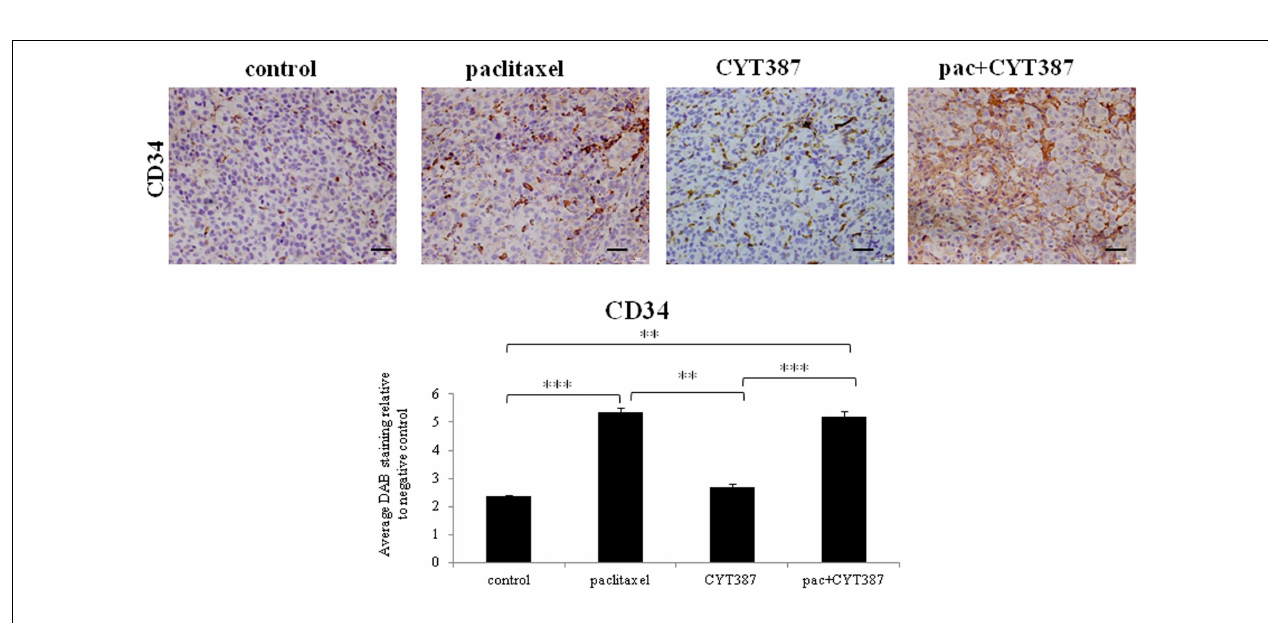
scale bar = 10 µ M. Average DAB intensity and proportion of staining of CD34 in xenografts was standardized to a negative control.The experiments were performed using five independent samples in each group. Significant intergroup variations are indicted by ** p < 0.01 and *** p <